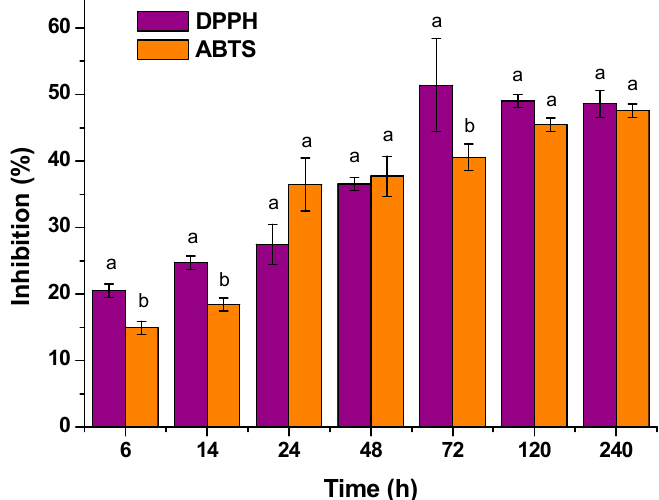
Figure 5. Comparison between DPPH and ABTS methods for PCL-TOC film (mean ± SD; n = 3). Different letters (a, b) at the same time indicate statistically different values between the studied methods ( p < 0.05).